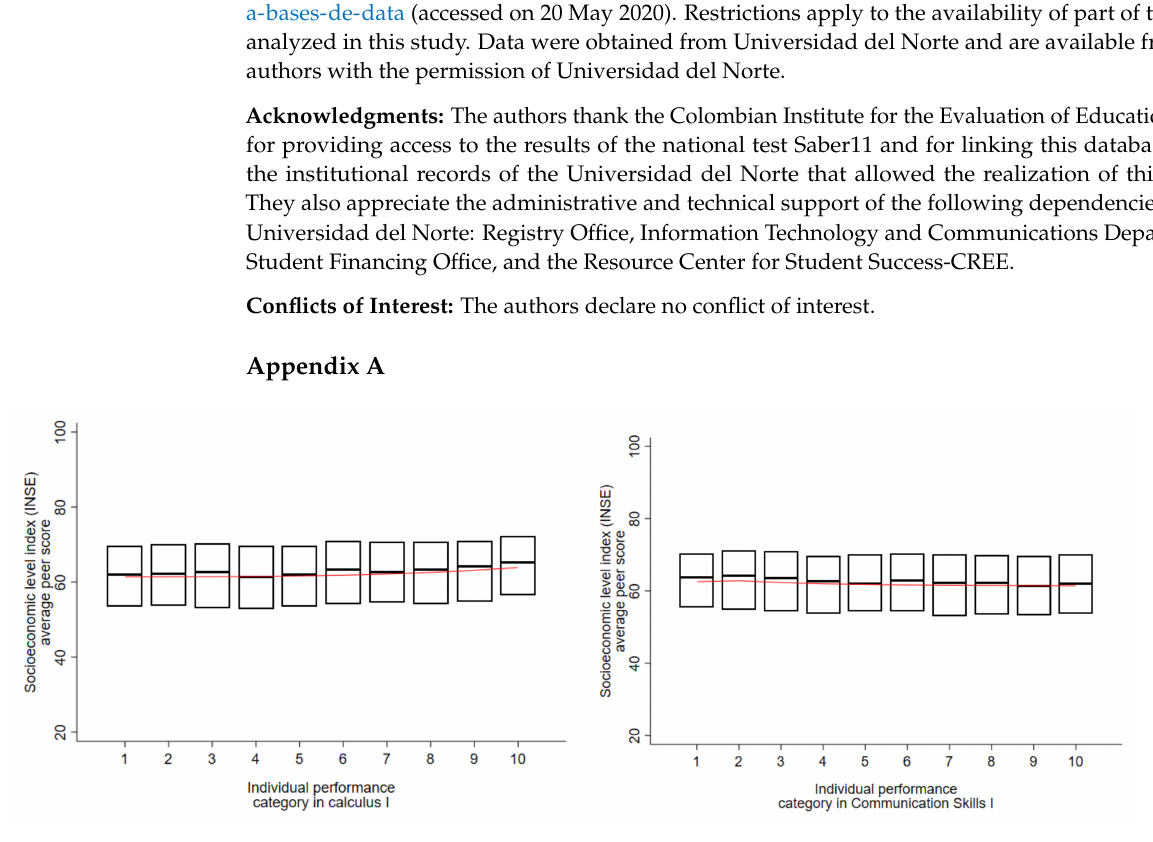
Figure A1. Distribution of the socioeconomic level index by student category. This is a calculation carried out by Icfes that brings together different factors, generally related to education, occupation and income, which interact for an adequate measurement of an individual’s well-being. Source: Authors’ preparation. Table A1. Final grade